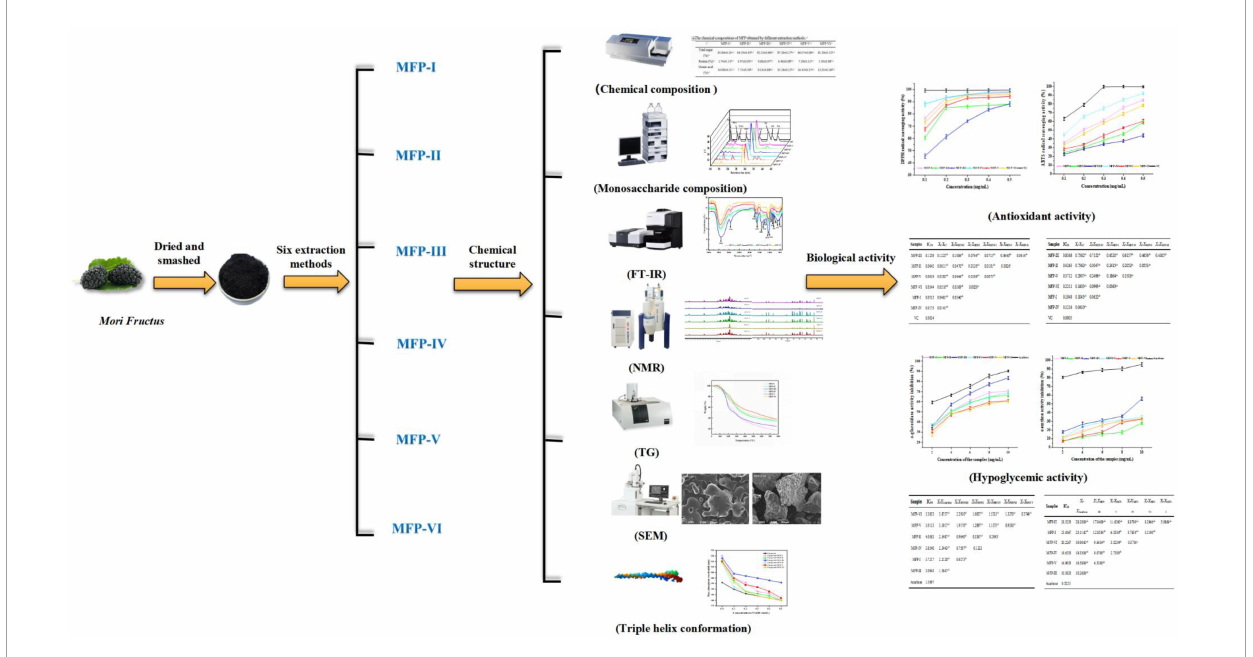
FIGURE1 Structural characterization and bioactivity of different fractions of mulberry